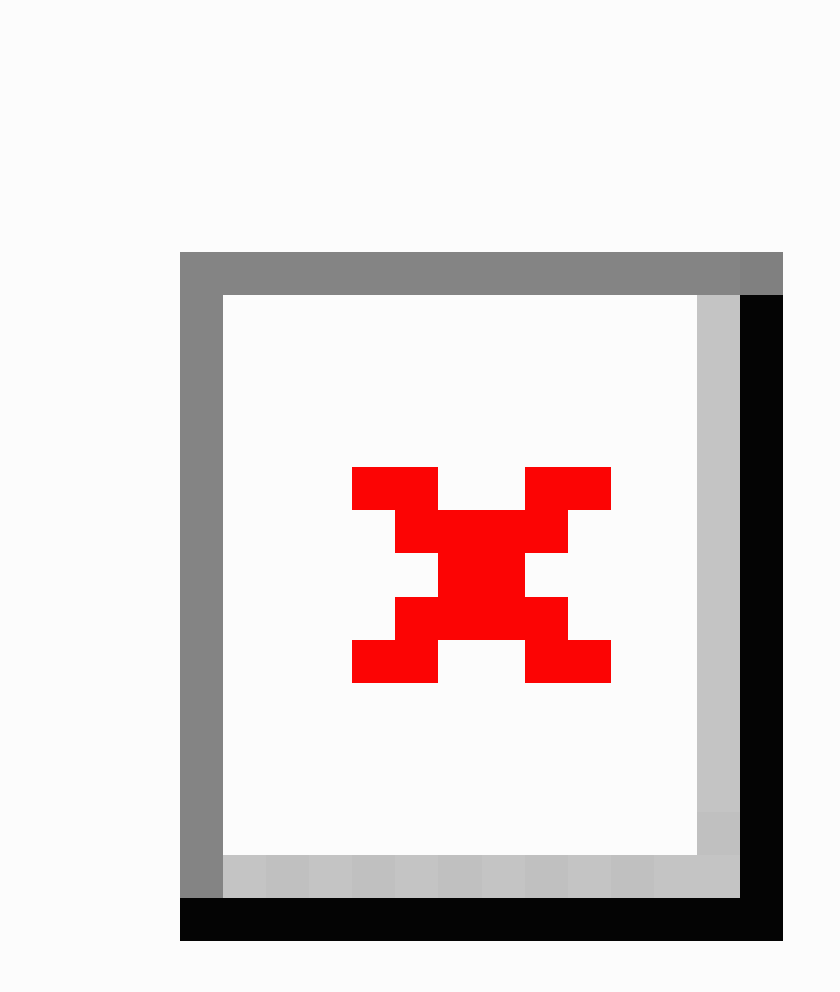
Figure 13. Selected virtual slide regions from sWSI (right) with good quality, compared to those from the Leica scanner (left).